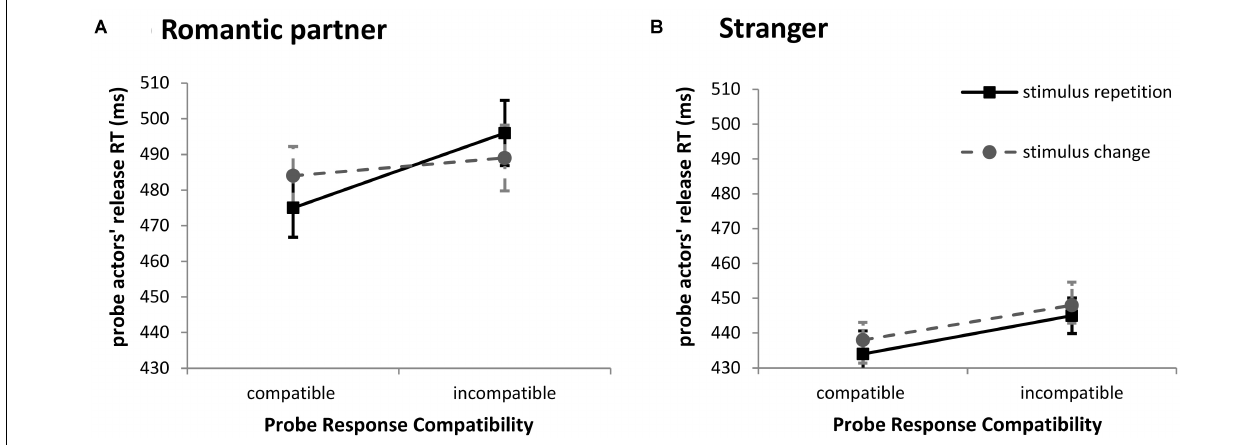
FIGURE 2 | Probe actors’ average release RT (ms) as a function of stimulus relation (stimulus repetition: solid lines; stimulus change: dotted lines), response compatibility between observed prime and executed probe response, and interaction partner ( A : probe performance of participants interacting with their own romantic partner; B : probe performance of participants interacting with a stranger). Error bars depict 95% confidence intervals for paired differences (CI PD ; Pfister and Janczyk, 2013), computed for the difference of stimulus change minus stimulus repetition (SC-SR) within each probe response compatibility